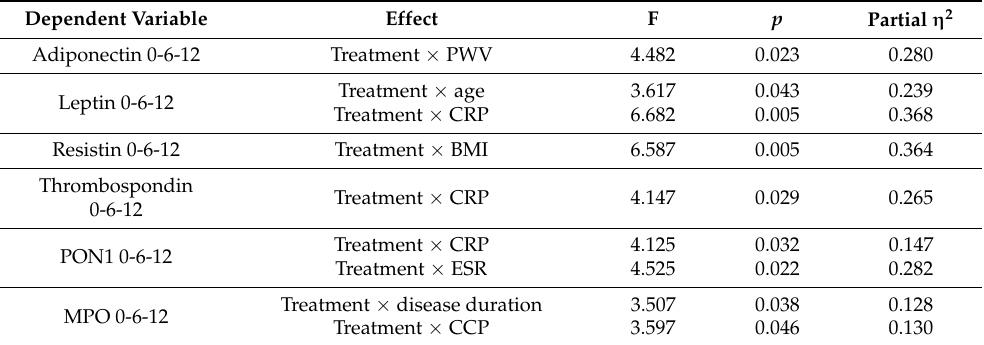
Table 3. Significant results of the general linear model repeated measures analysis of variance (RM- ANOVA) test determining the effects of treatment and other independent variables on metabolic parameters as dependent